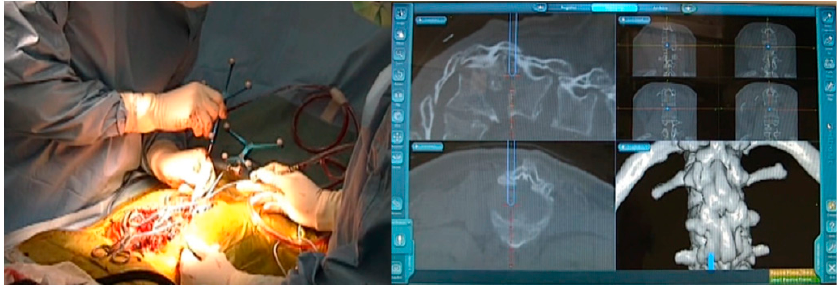
Figure 3. A 16-year-old girl with achondroplasia; intraoperative image and navigation.